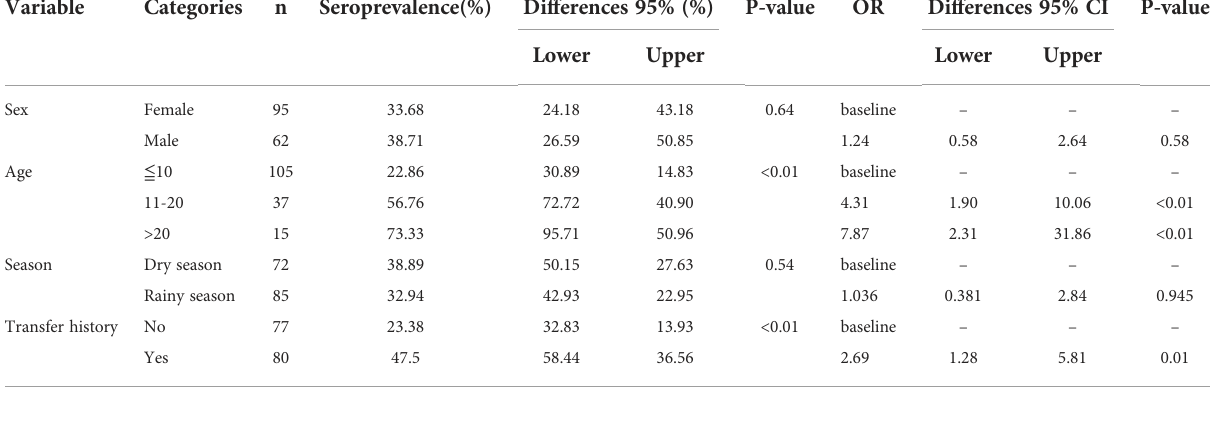
TABLE 4 Seroprevalence and risk factors associated with seropositivity of T. gondii in the giant panda. Variable